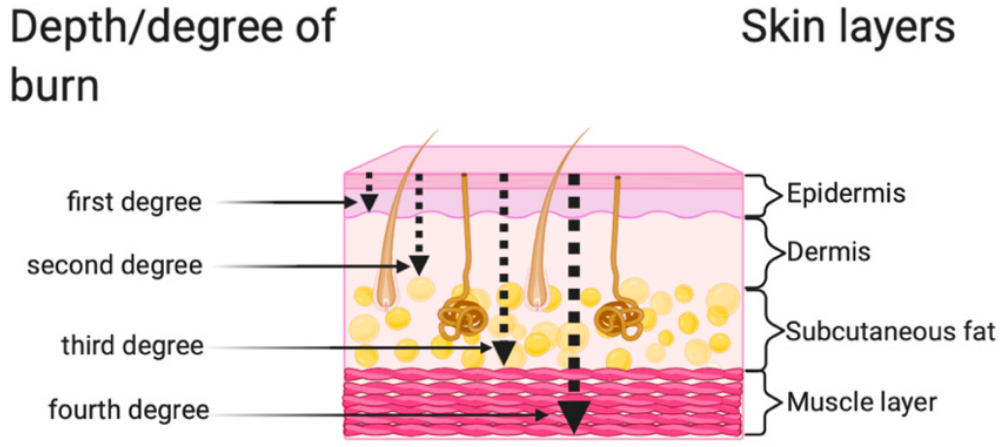
Figure 1. Classification of burn wound depth [7–9].